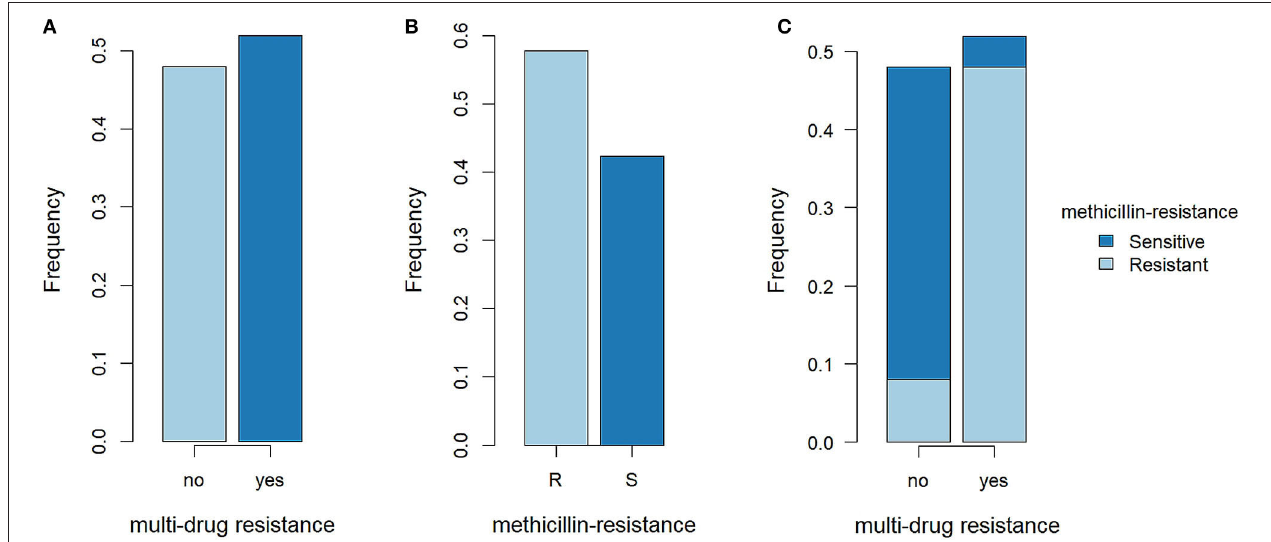
FIGURE 1 | Methicillin resistance and multi-drug resistance in SP isolates. (A) Proportions of multidrug-resistant (MDR) SP and not MDR SP. R, resistant; S, sensitive. (B) Proportions of methicillin-resistant SP (MRSP) and methicillin-sensitive SP (MSSP). (C) Proportions of MRSP and MSSP in MDR SP and not MDR SP.